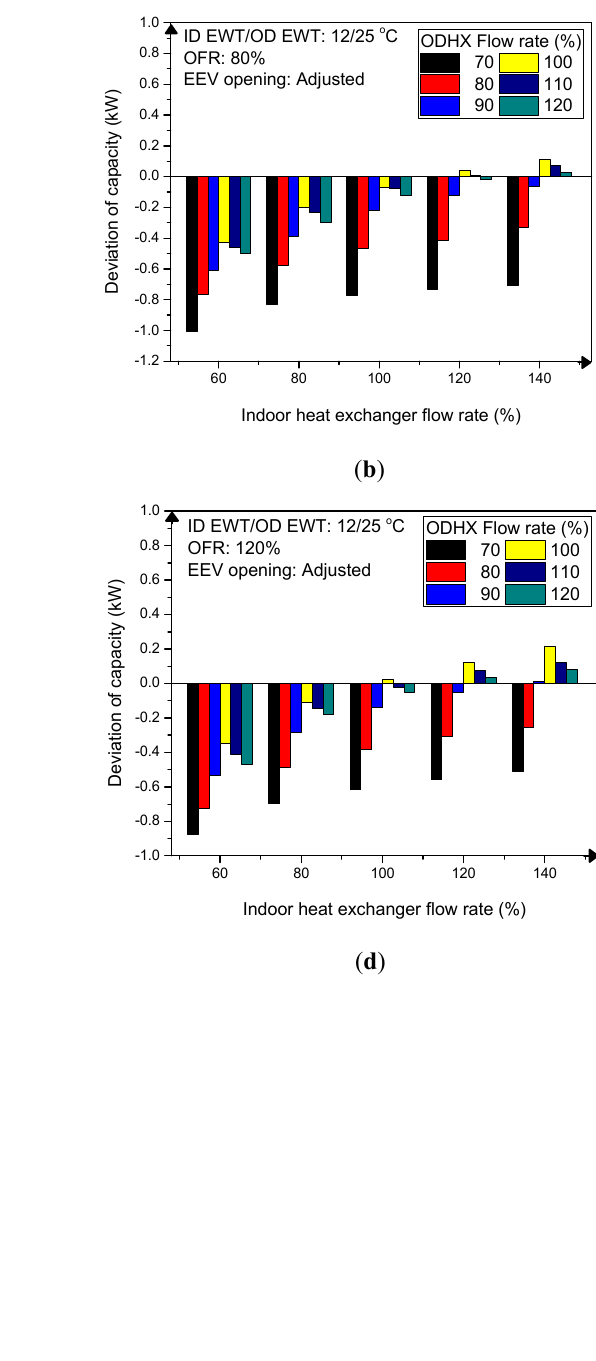
10 of 19 Table 3. Simultaneous faults in refrigerant charge and flow rate of secondary fluid of outdoor heat